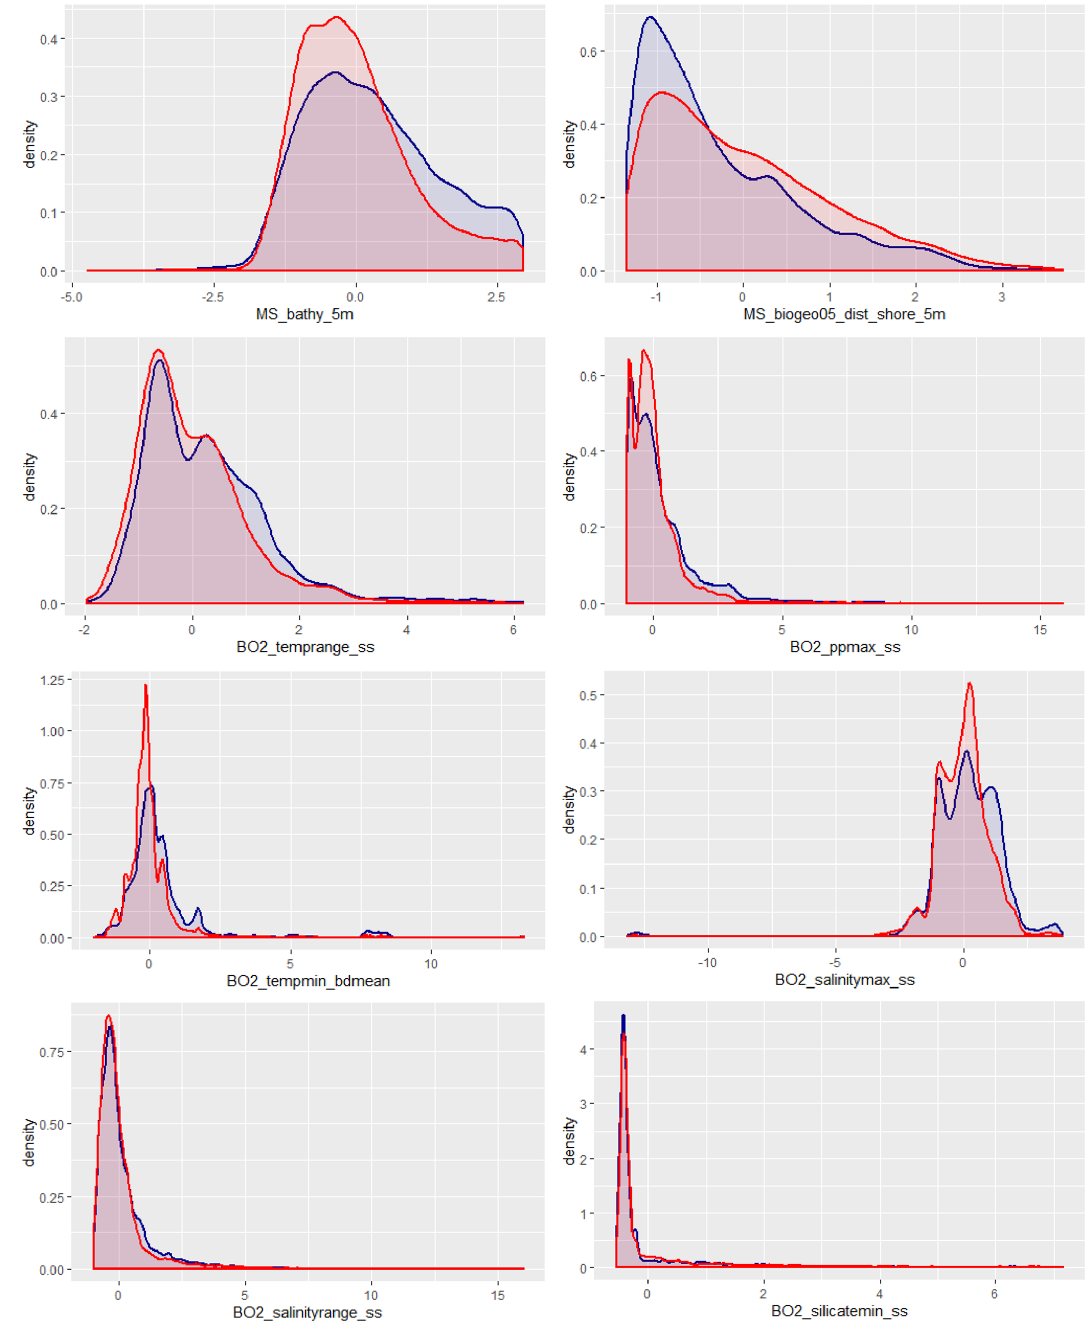
Figure 5. A visual check to what extent the samples cover the environmental space. Blue: samples; red: environmental data.